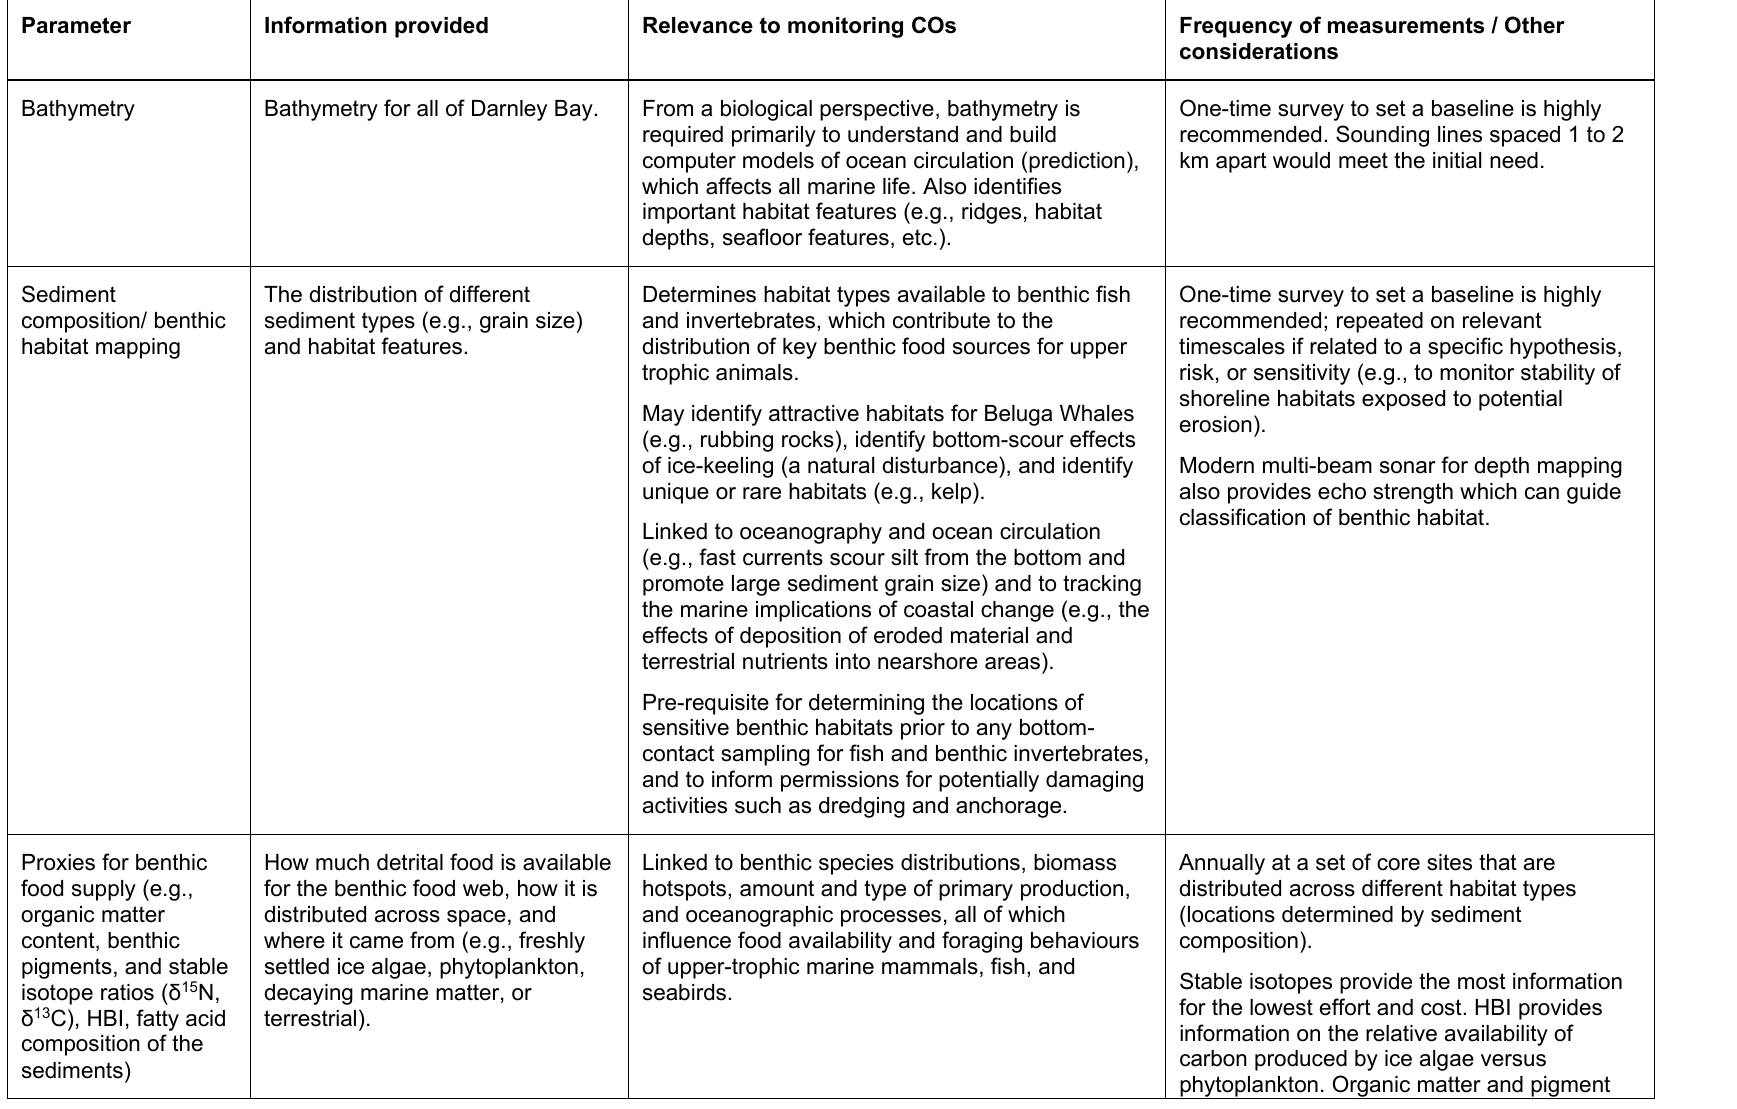
Table C3. Key measurement parameters for monitoring benthic habitat distributions (Section